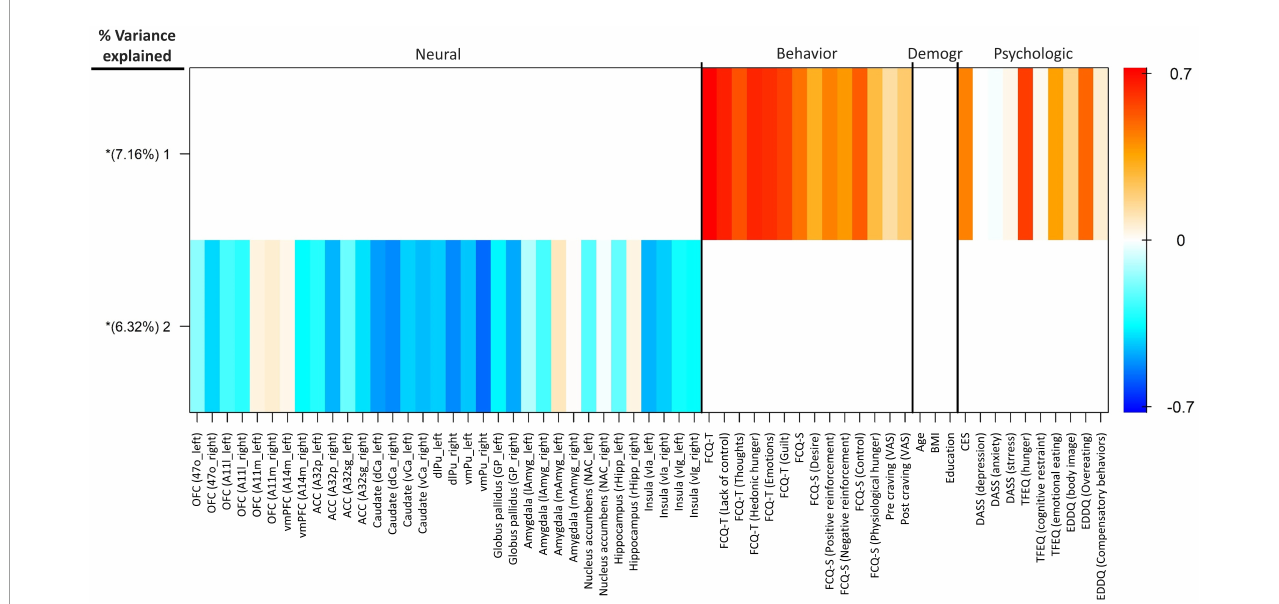
FIGURE5 Group factor analysis. Heatmap colors represent the weight of each variable loading. The x-axis shows the variables included in each group. Extracted robust group factors and the percentage of variance explained by each are shown on the y-axis. Asterisks show group factors that contained at least one loading weight whose 95% credible interval did not contain 0. OFC, orbitofrontal cortex; vmPFC, ventromedial prefrontal cortex; ACC, anterior cingulate cortex; dCa, dorsal caudate; vCa, ventral caudate; dlPu, dorsolateral putamen; vmPu, ventromedial putamen; GP, globus pallidus; lAmyg, lateral amygdala; mAmyg, medial amygdala; NAc, nucleus accumbens; rHipp, rostral hippocampus; vIa, ventral agranular insular; vIg, ventral granular insular; FCQ-S, food craving questionnaire-state; FCQ-T, food craving questionnaire-trait; VAS, visual analog scale; BMI, body mass index; CES, compulsive eating scale; DASS, depression anxiety stress scales; TFEQ, three-factor eating questionnaire; EDDQ, eating disorder diagnostic questionnaire; Demogr,